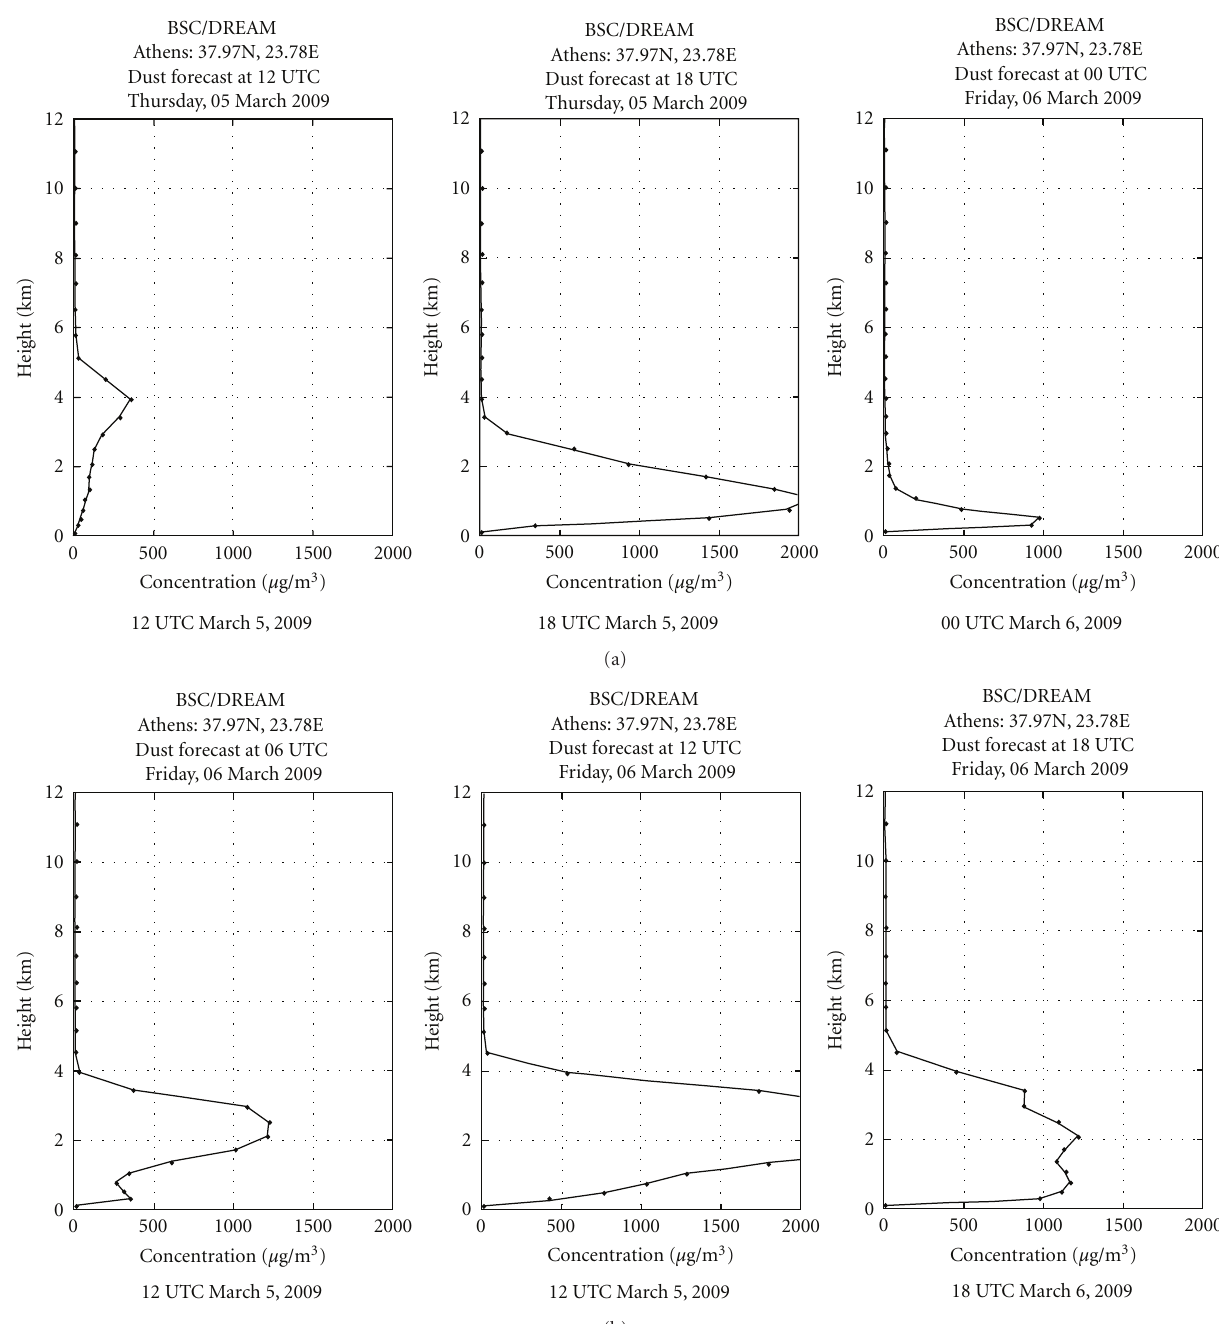
Figure 9: DREAM 6-hour vertical profile of dust forecast for March 5, 2009 (a) and March 6, 2009 (b).